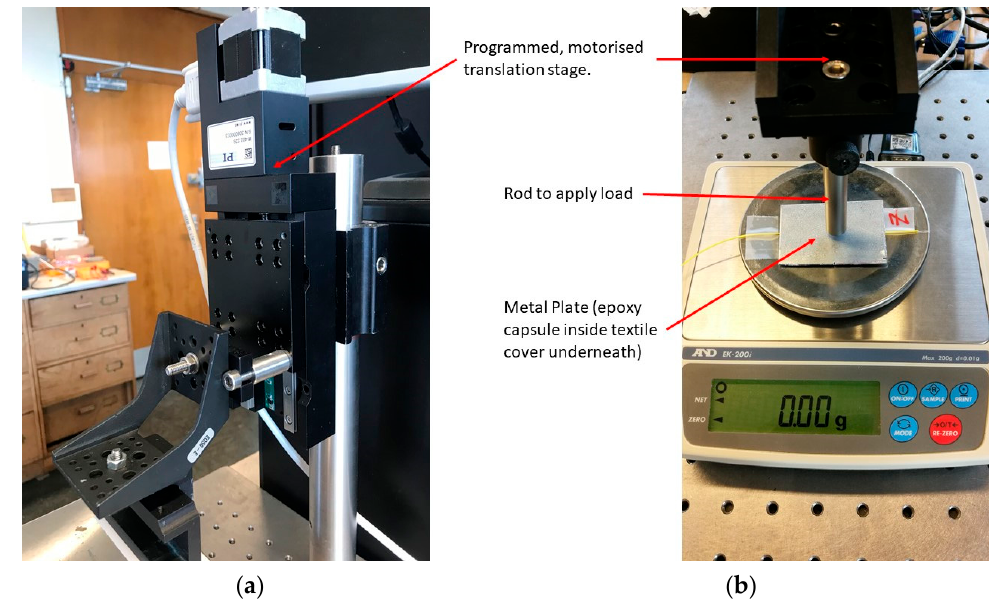
Figure 2. Customised calibration setup. ( a ) The motorised translation stage is programmed to lower the rod onto the weighing scale. The pressure sensor in its textile housing is attached to the plate of the weighing scale to keep it in place during the calibration. ( b ) The load is transferred from the translation stage to the pressure sensor via a metal rod and an aluminium metal plate. The probe is lined up over the central FBG of the sensor before starting the loading process.